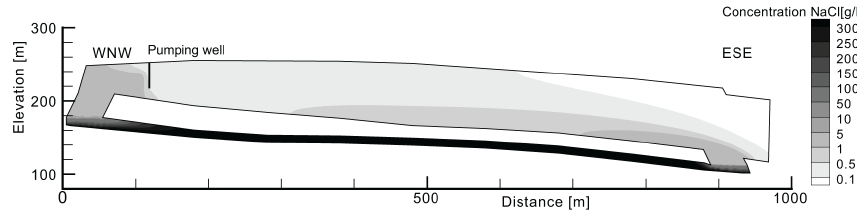
Figure 6. NaCl concentration distribution over the domain with 40m wide fault zone after 3years of simulations.